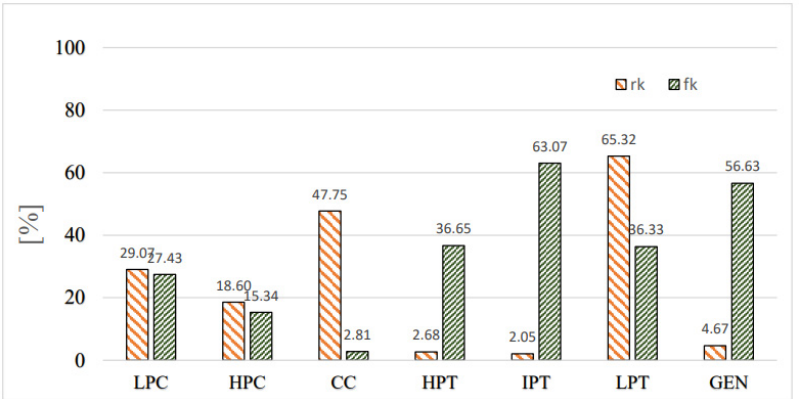
Figure 7. Exergoeconomic factor ( 𝑓 𝑘 ) and relative difference in cost ( 𝑟 𝑘 ) for the main components of the GT engine (Centrifugal-centrifugal compressor).